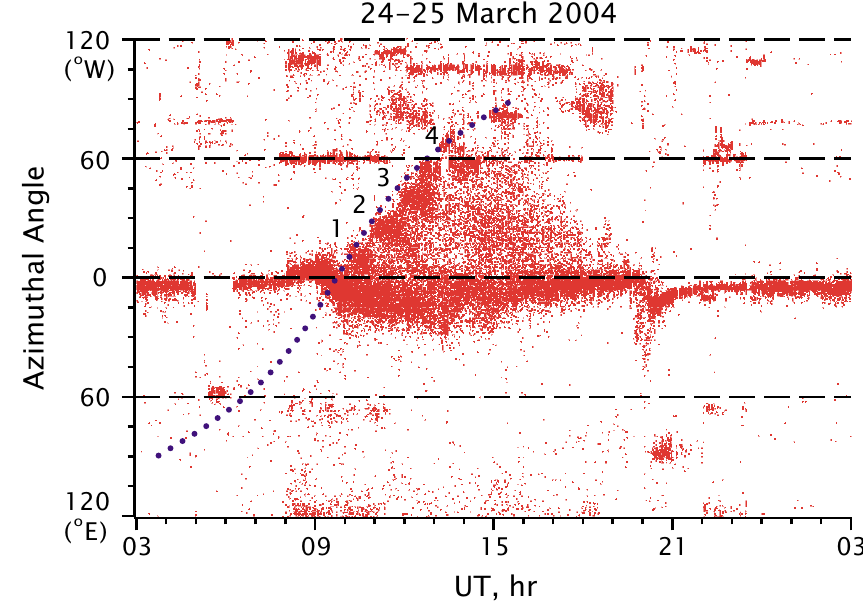
Fig. 5. The same as for Fig. 3, but for 24–25 March